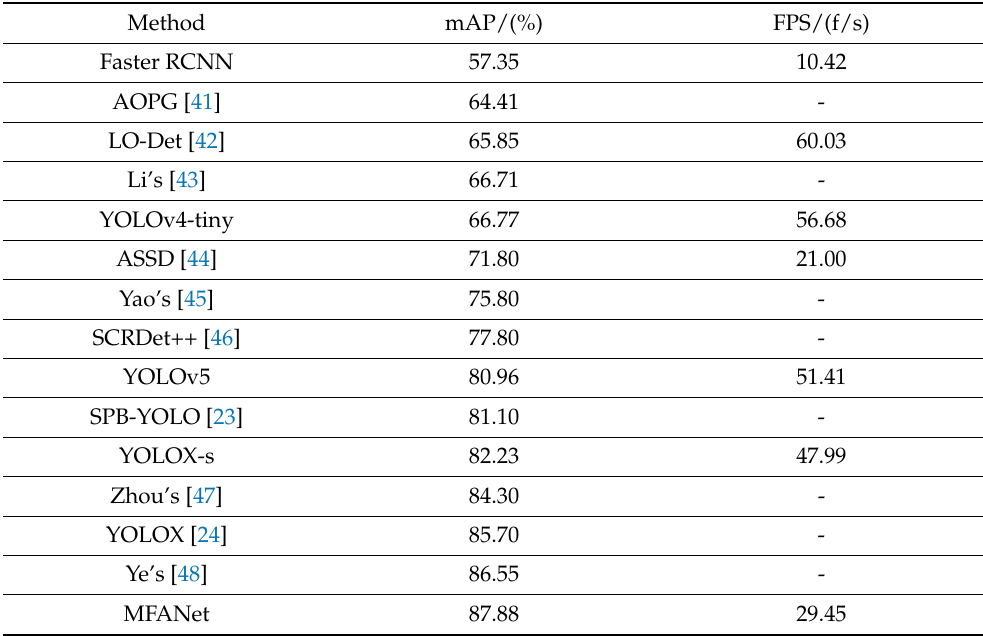
Table 4. Experimental results in the DIOR dataset. FPS stands for frame per second and mAP stands for mean average